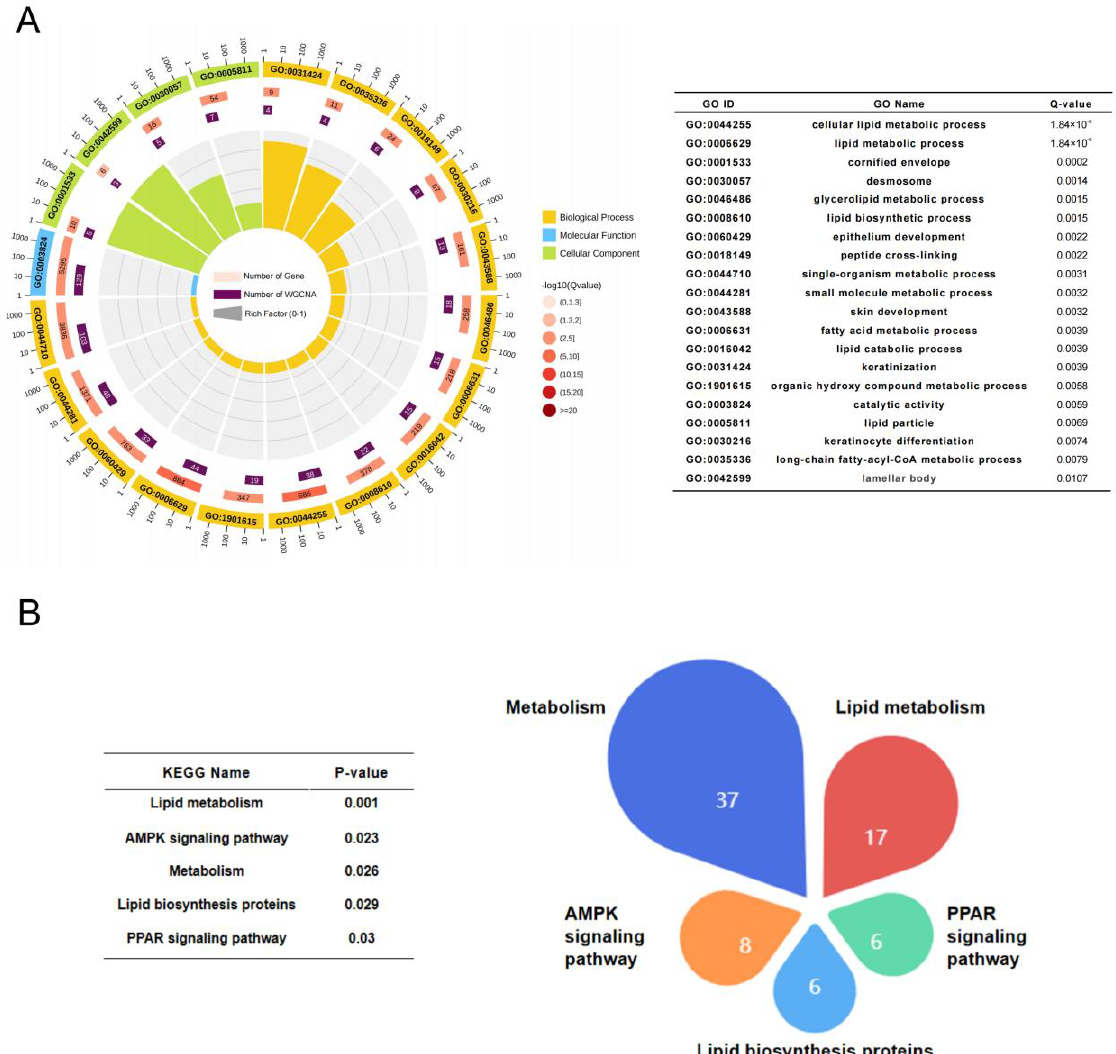
Figure 2. Co-expressed genes in yellow module. ( A ) The top 20 Gene Ontology (GO) terms identified with yellow module genes. ( B ) Pie chart of all significant pathways (Q-value < 0.05) in the yellow module. Each sector of the pie chart is proportional to the number of genes in the pathway.